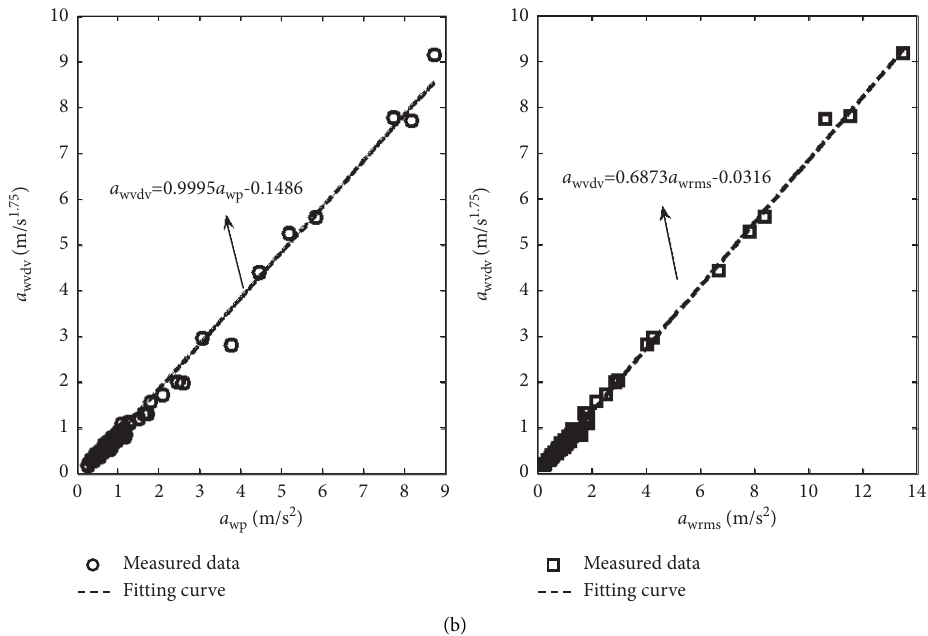
Figure 8: a wvdv plotted against a wp and a wrms. (a) Shaking table measured data; (b) crowd induced measured data.